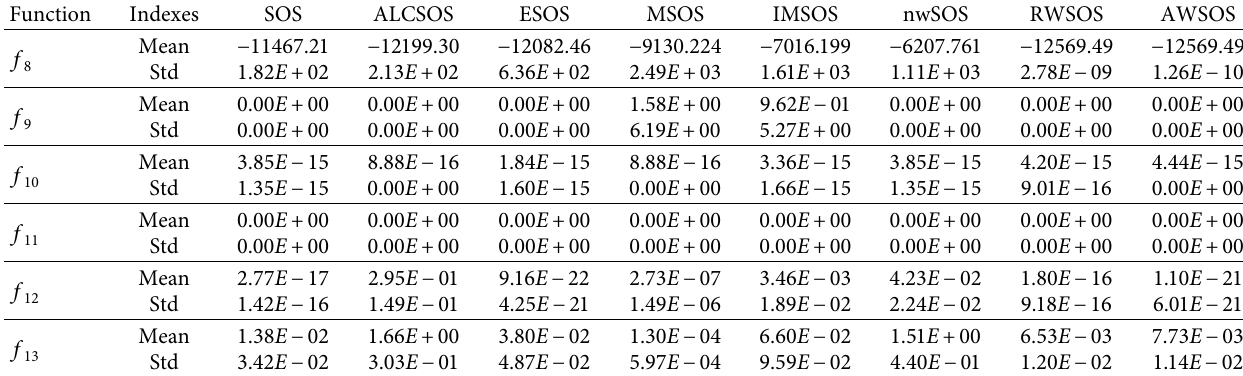
Table 12: Results of the SOS and variants on multimodal functions.